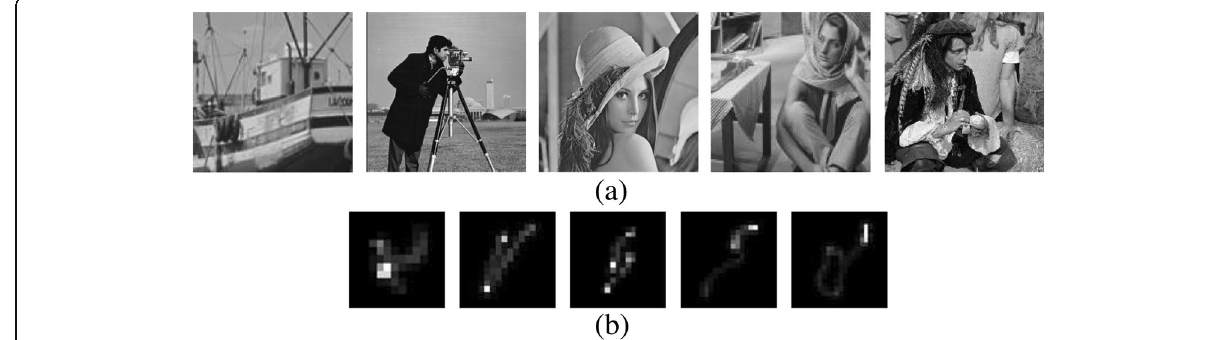
Fig. 2 Dataset for the numerical experiments. a Test images (from 128 × 128 to 1024 × 1024). b Blur Kernels (from 13 × 13 to 23 ×